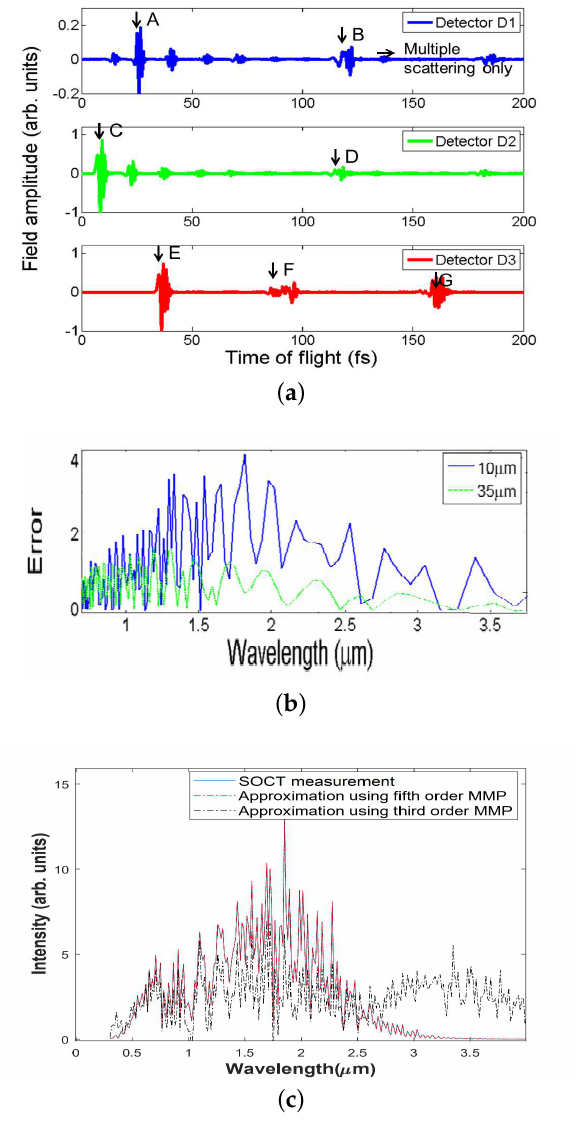
Figure 3. ( a ) Schematic of a single pulse light travelling in a sample consisting of the two scatterers; ( b ) spectra error; and ( c ) spectra obtained using MMP terms of different